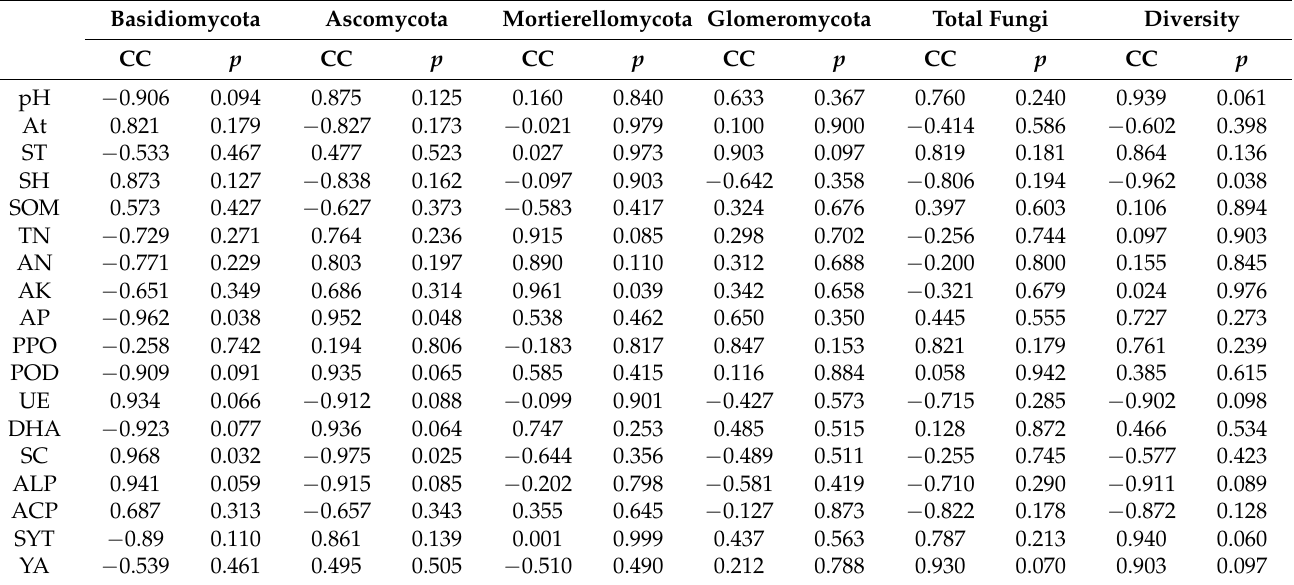
Table 4. Pearson correlation analysis of fungi community.